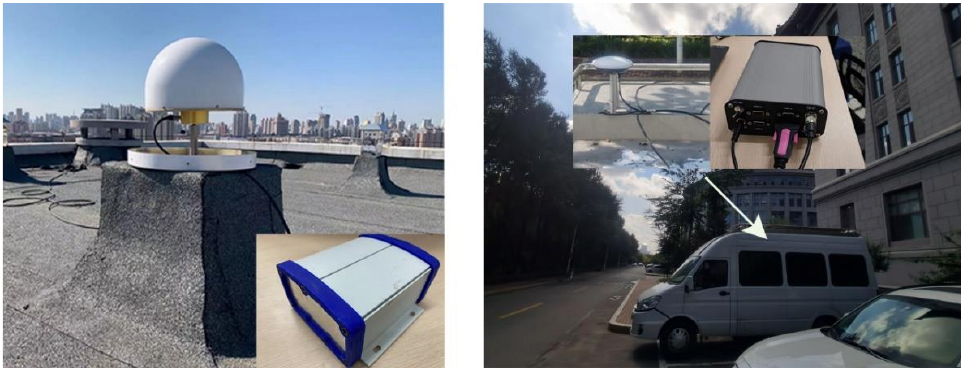
Figure 7. Schematic diagram of reference station ( left ) and vehicle-mounted kinematic experimental device ( right ).